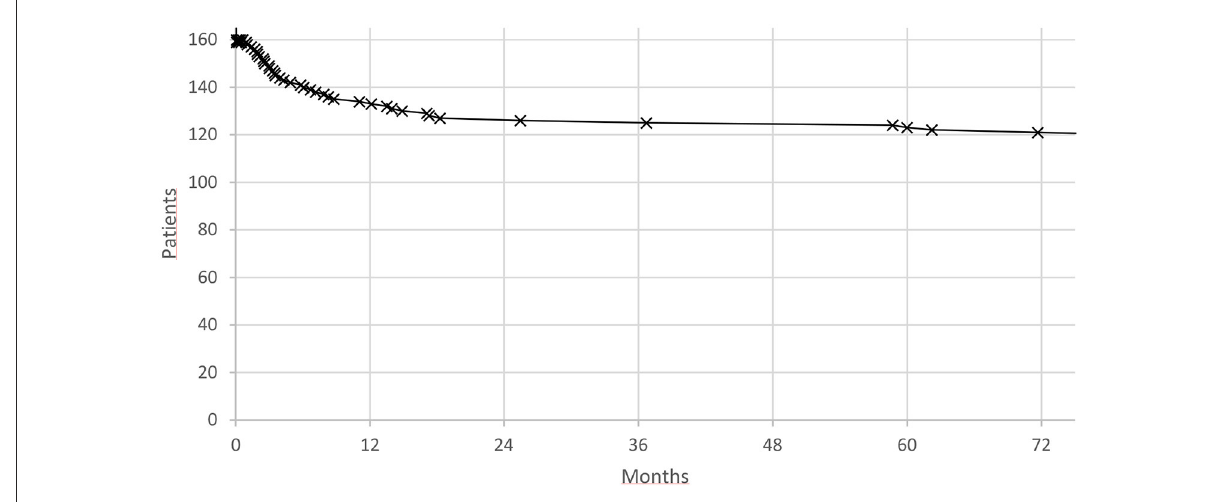
FIGURE1 Electrical storm recurrence.